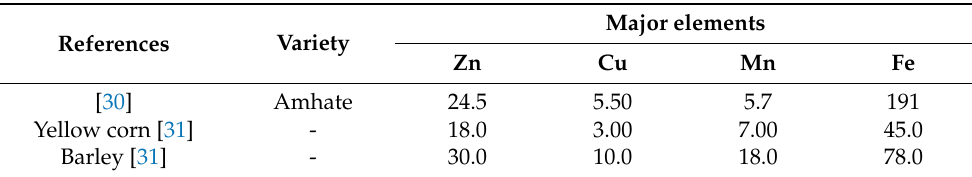
Table 6. The trace element content (mg/kg of dry matter) of different varieties of date stone meal compared with yellow corn and